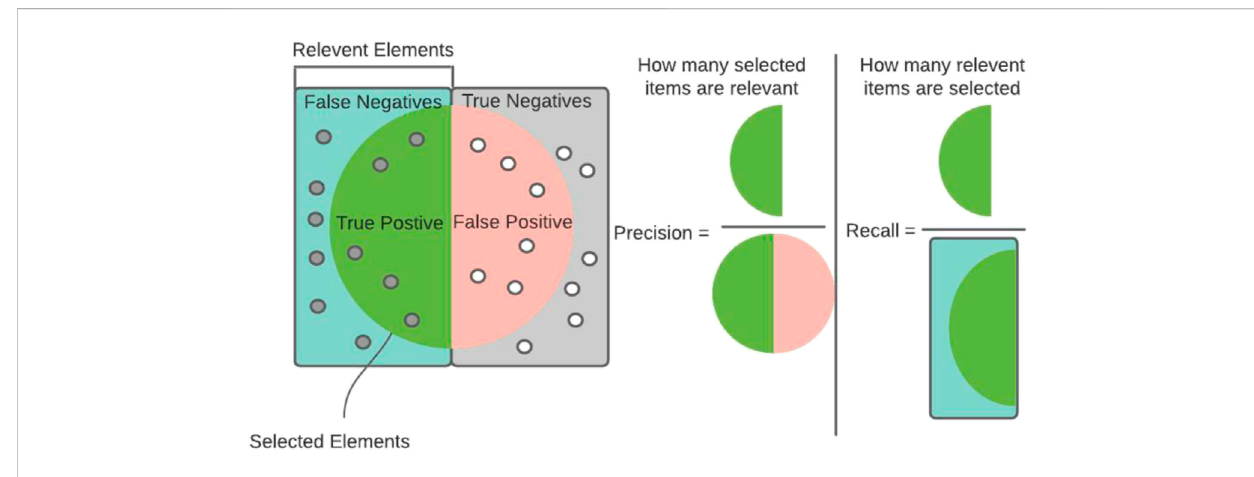
FIGURE 8 Precision and recall (Powers, 2020).